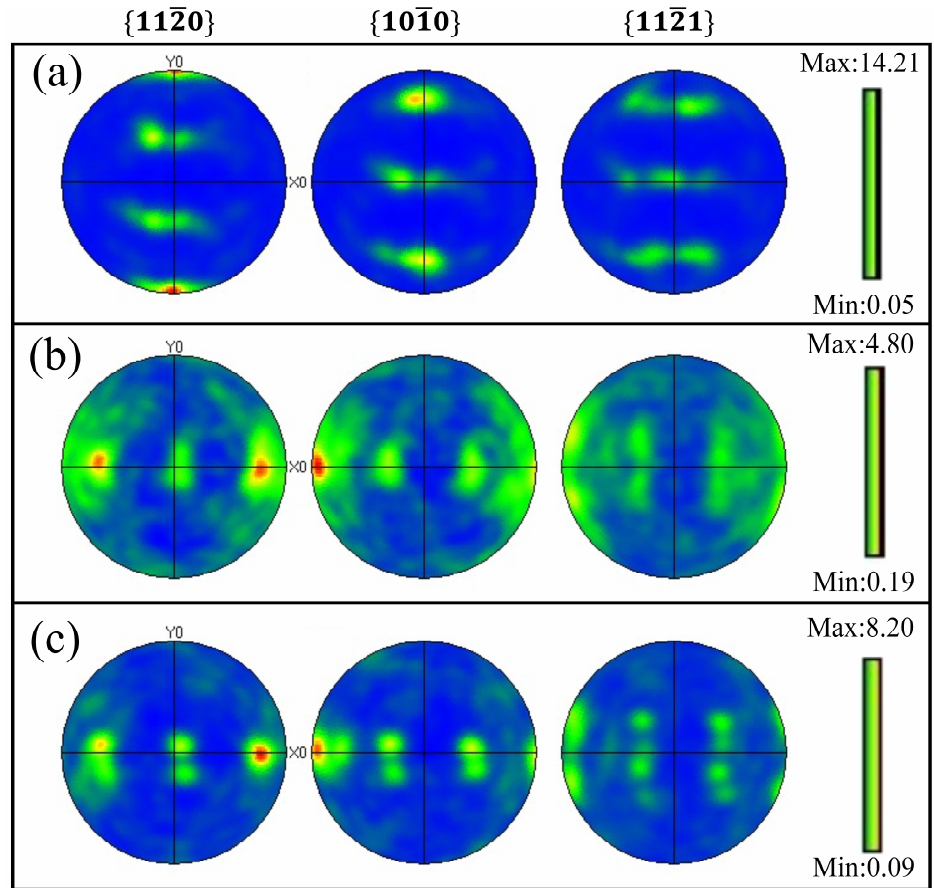
Figure 8. EBSD pole figures of experimental coupons before and after LSP treatment: ( a ) untreated, ( b ) 6J-1time, and ( c ) 6J-3times.